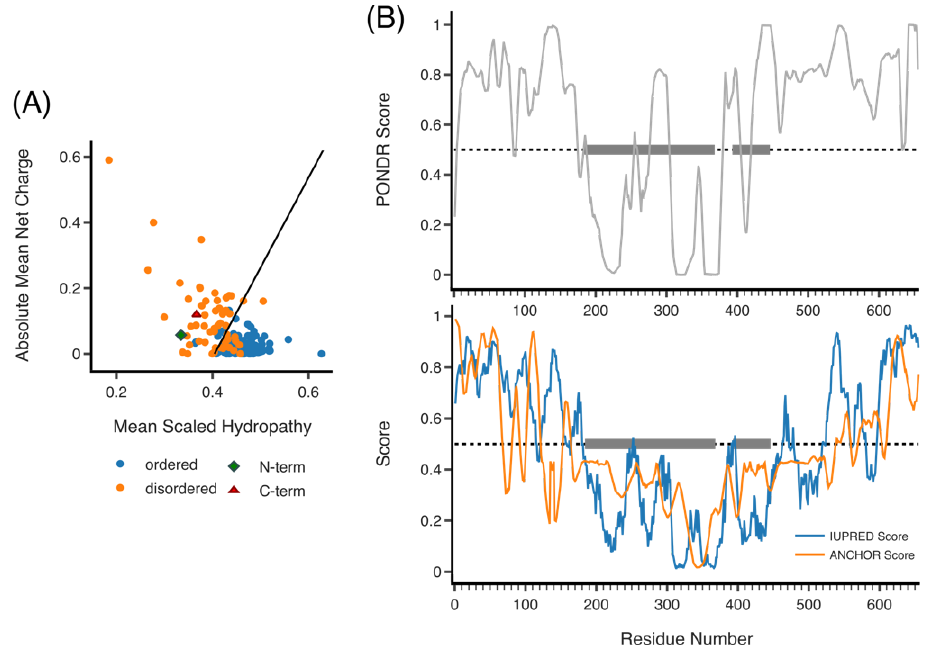
Figure 4. Predicted disorder of RLIP76. ( A ) Hydropathy plot of RLIP76 N- and C-termini (green diamond and red triangle, respectively), the remaining plotted proteins (ordered, blue and disordered, orange) are from the PONDR data set. RLIP76 lies to the left of the boundary line for disordered proteins. ( B ) PONDR plot of disorder across residues 1–655 (full length) RLIP76 (top). IUPRED plot of disorder (blue) and ANCHOR score (orange) across residues 1–655 (bottom). In both PONDR and IUPRED scores above 0.5 are disordered. ANCHOR scores above 0.5 predict regions that are likely to fold upon binding. Grey boxes highlight the locations of the RhoGAP and RBD.